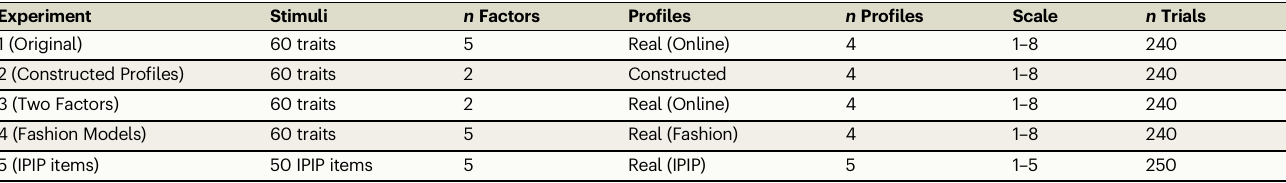
Table 1 | Overview of the stimuli for the fi ve experiments